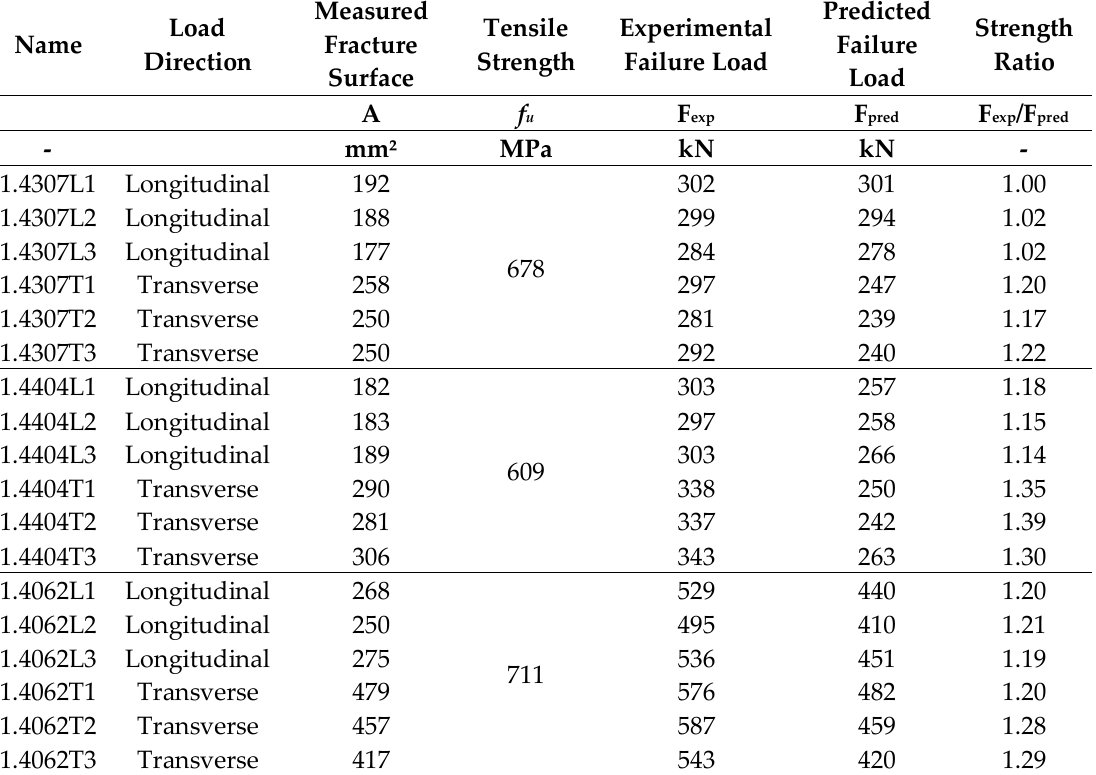
Table 3. Overview of test results and predicted strengths based on engineering f u .